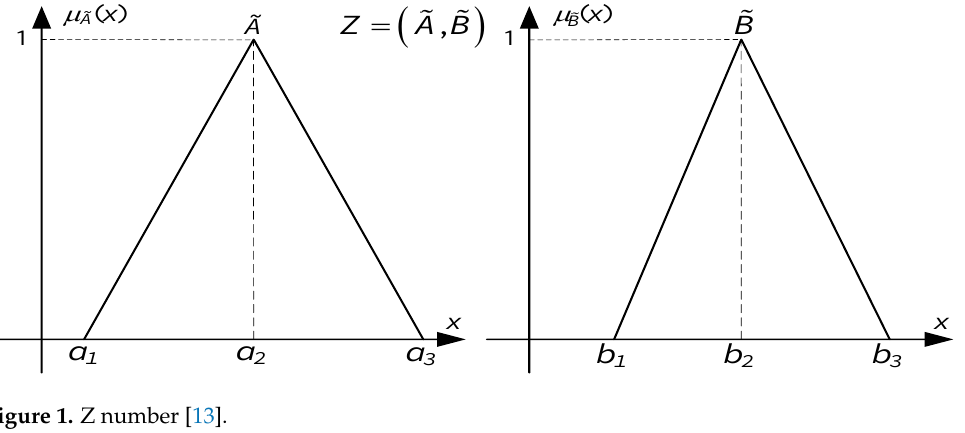
Figure 1. Z number